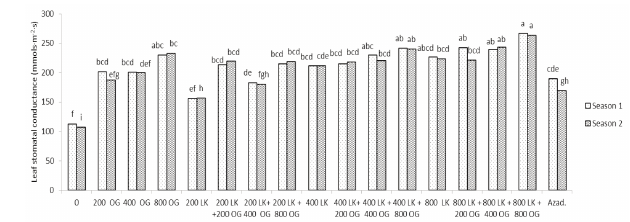
Fig. 5 ­ Effect of fresh plant organic amendments on tomato plant stomatal conductance taken after two week inter­ val. Means followed by the same letter in a letter series within a column per season are not significantly different according to Tukey’s honestly significant difference (THSD) at P ≤ 0.05. OG = Ocimum gratissimum L. and LK = Lippia kituensis Vatke, are Soil organic amendments in g/10Kg soil, 0= no amendment (soil),